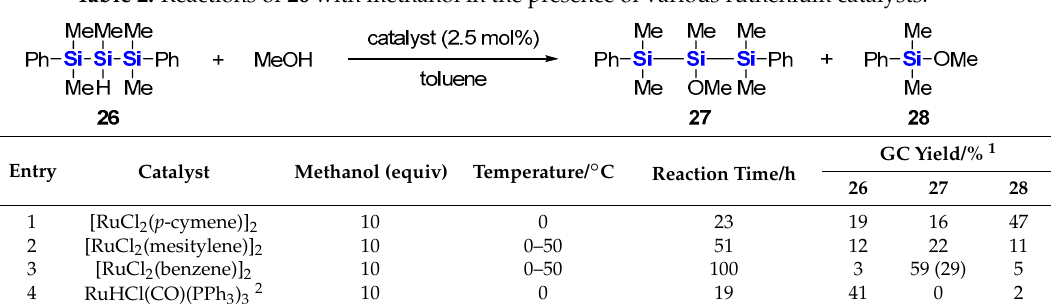
Table 2. Reactions of 26 with methanol in the presence of various ruthenium catalysts.